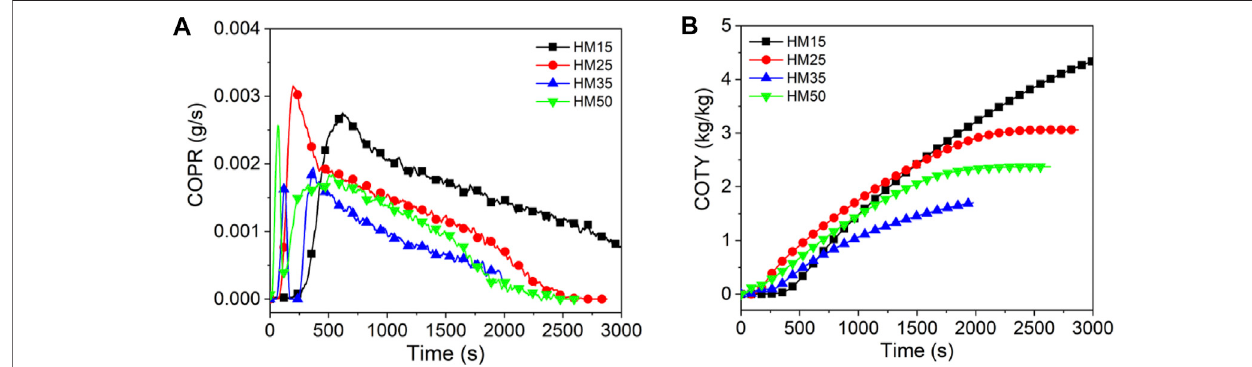
FIGURE 7 | Lignite curves: (A) PCOPR, and (B) COTY.